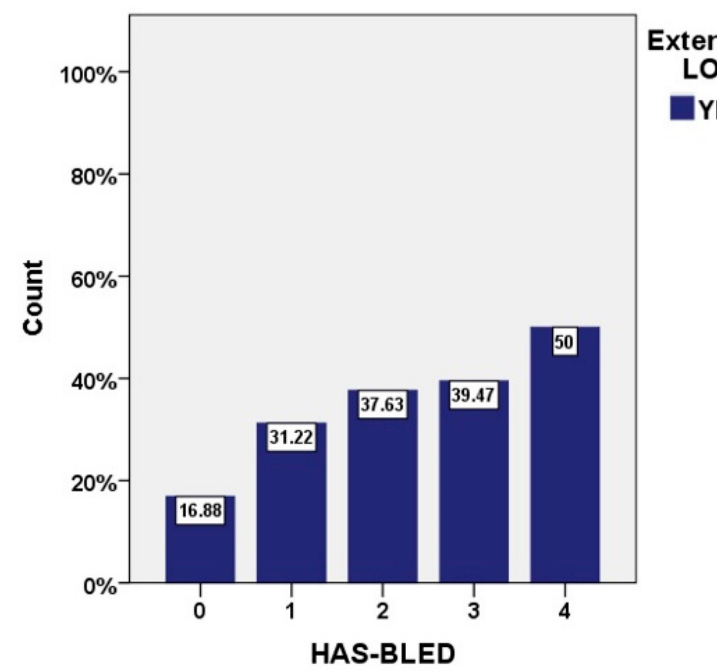
Figure 3. Incidence of prolonged LOS stratified by the HAS-BLED score.